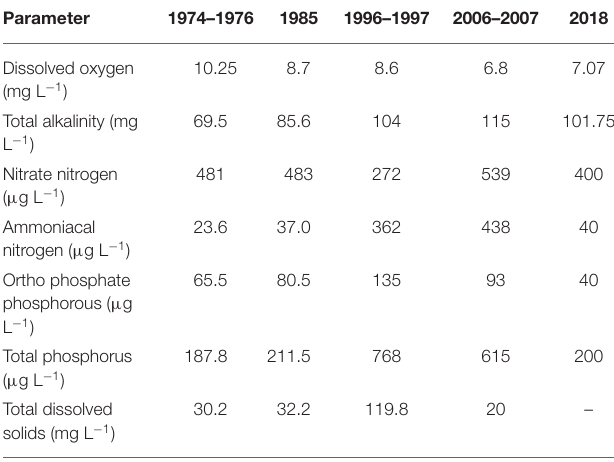
TABLE 4 | Water quality changes in Dal ecosystem (Source: Trisal, 1977; Abubakr and Kundangar, 2009; Khanday et al.,